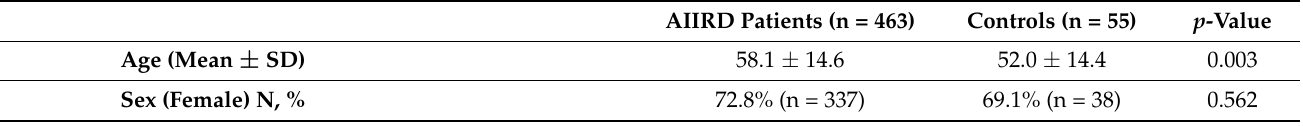
Table 1. Baseline characteristics of the study